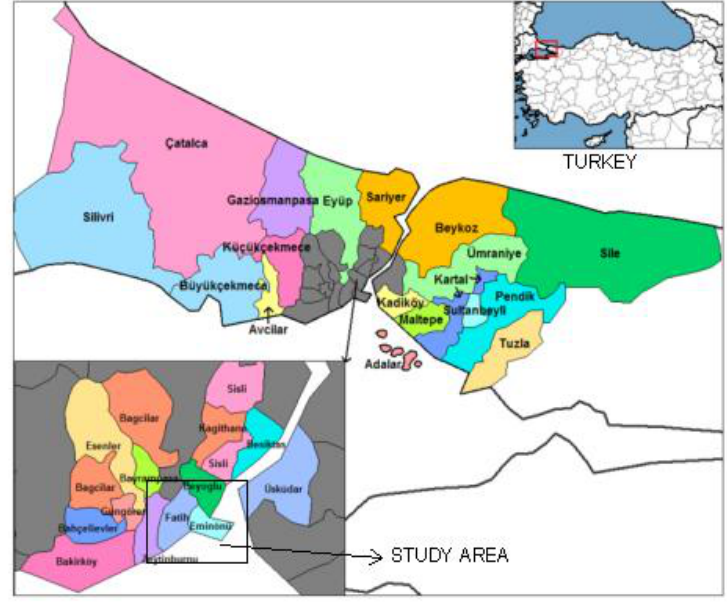
Fig. 1. Location of the study